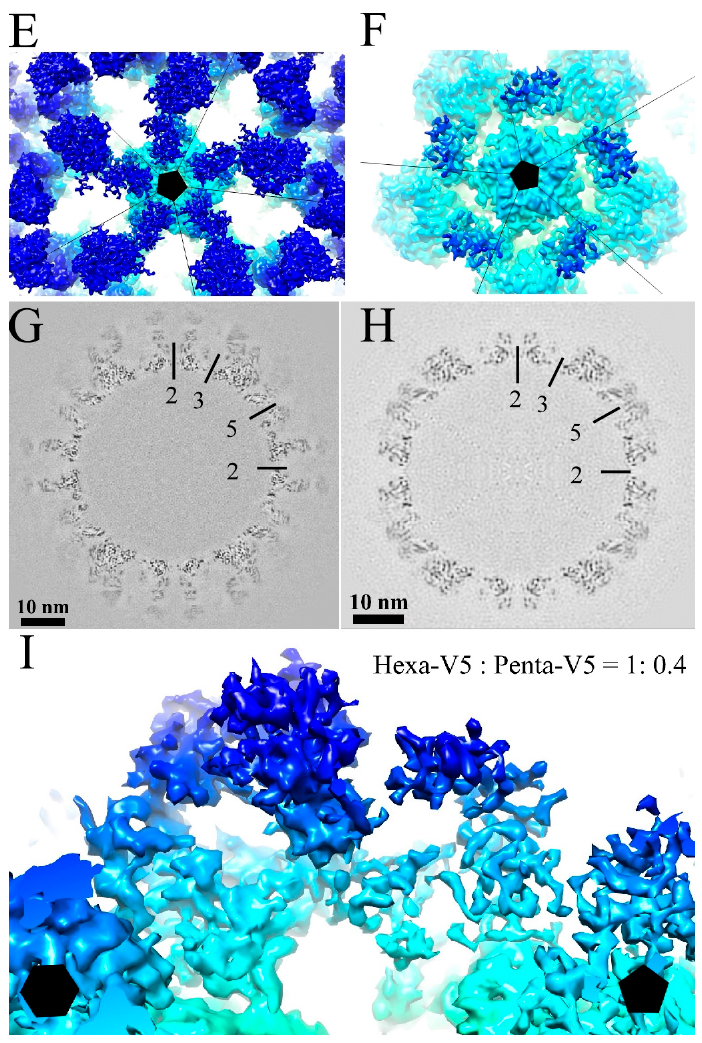
Figure 1. Cryo-electron microscopy (Cryo-EM) reconstructions of HPV16-V5 and HPV16-U4. Representative regions of cryo-EM micrographs of the HPV16-V5 ( A ) and HPV16-U4 ( B ) virus-fab complexes; ( C , D ) the surface rendered 3D maps of HPV16-V5 ( C ) and HPV16-U4 ( D ) were radially colored according to the distance from the center (color key in Ångstroms) of the capsid and surface rendered at 1 σ ; ( E , F ) the zoom-in view of the five-fold vertex (black pentagon) of V5 ( E ) and U4 ( F ) maps shows the density corresponding to bound Fab molecules (dark blue); ( G , H ) the central sections through the cryo-EM density maps show the quality of the reconstructions. Capsids were cut vertically through the two-, three- and five-fold icosahedral symmetry axes (black lines), with the central two-fold axis appearing at the 12 o’clock position; ( I ) the V5 Fab densities associated with the hexavalent (black hexagon) and pentavalent (black pentagon) capsomers showed different magnitudes. The magnitude ratio between hexavalent Fab (Hexa-V5) and pentavalent Fab (Penta-V5) was measured as 1:0.4.